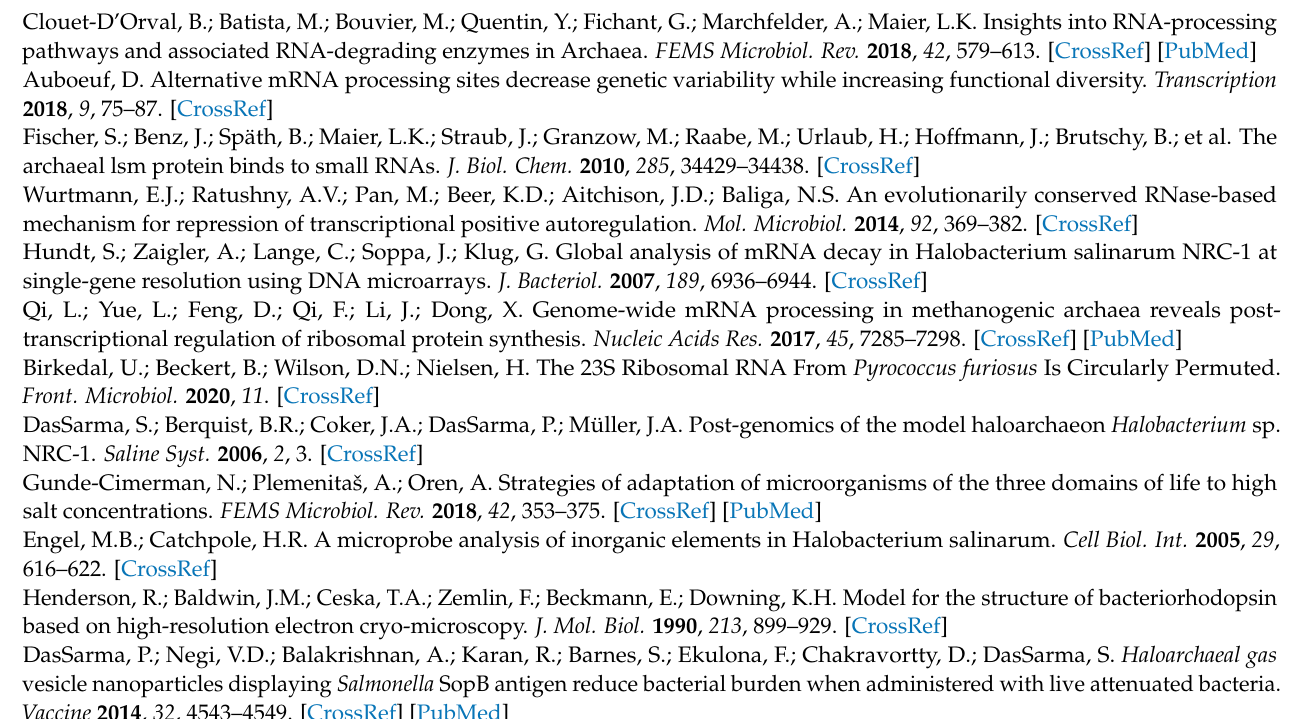
Table S7: Internal TPS present in H. salinarum with no correspondent in H. volcanii . Table S8: Internal TPS present in H. volcanii with no correspondent in H. salinarum . Table S9: Antisense transcript processing sites (aTPS) identified in H. salinarum. Table S10: Antisense transcript processing sites (aTPS) identified in H. volcanii . Table S11: TPS and aTPS pairs in H. salinarum . Table S12: TPS and aTPS pairs in H. volcanii . Table S13: Conserved TPS co-localized with local Ribo-seq peaks in H. salinarum . Table S14: Putative conserved rancRNAs between H. salinarum and H. volcanii . File S1: Gaggle Genome Browser file with dRNA-seq data and TPS positions in H. salinarum NRC-1. File S2: Gaggle Genome Browser file with dRNA-seq data, rancRNA and TPS positions in H. volcanii DS2. File S3: GGB file with TEX − data at exponential and stationary phases in H. salinarum . File S4: GGB file with Ribo-seq data and conserved TPS in H. salinarum